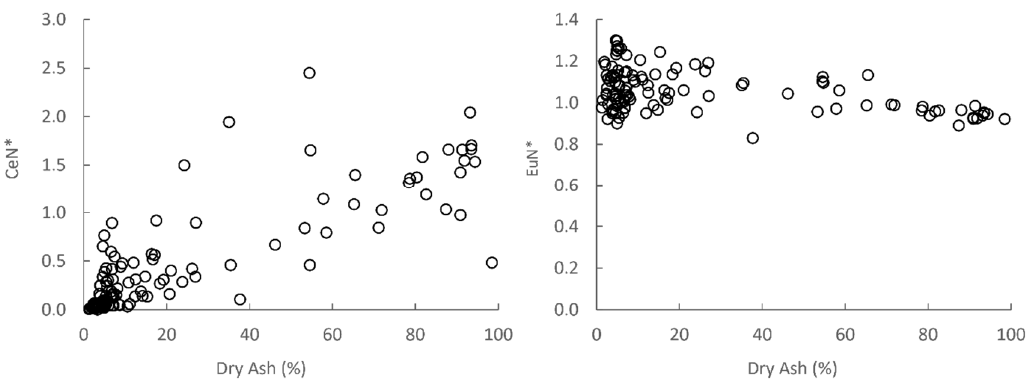
Figure 3. Cross plots ( left ) total REE in ppm on ash basis and ( right ) HREE/LREE ratios versus ash content.